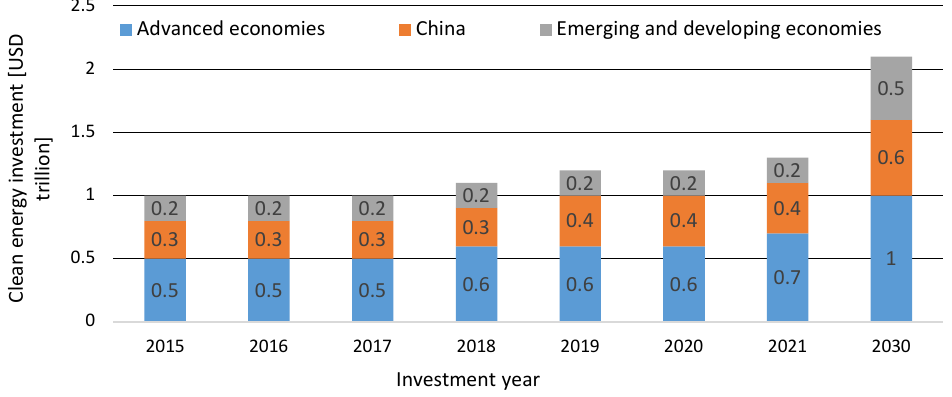
Figure 10. Global total energy supply from renewables and waste [35].